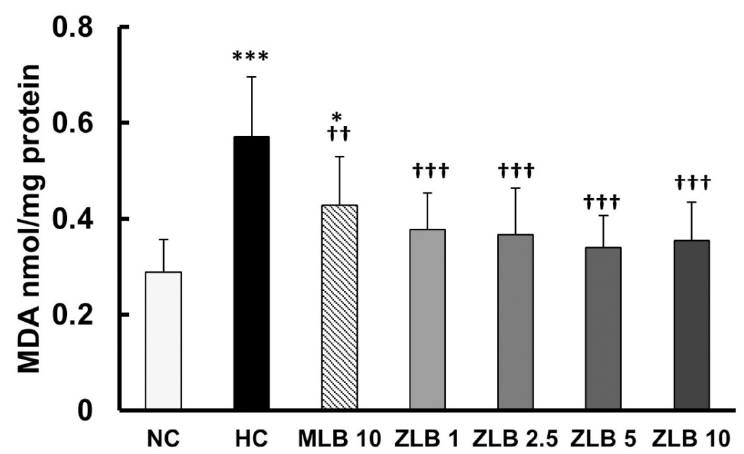
Figure 7. E ff ects of MLB and ZLB on oxidation stress. Malondialdehyde (MDA), a byproduct of Figure 7. Effects of MLB and ZLB on oxidation stress. Malondialdehyde (MDA), a byproduct of lipid lipid peroxidation, was measured by a thiobarbituric acid reactive substances (TBARS) assay as an indicator of oxidative stress. NC, normal diet control; HC, high-fat-diet (HFD) control; MLB10, HFD with 10 mg / kg / day of MLB; ZLB1, ZLB2.5, ZLB5, and ZLB10, HFD with 1, 2.5, 5, and 10 mg / kg / day of ZLB. Values are expressed as mean ± SD (n = 6 per group). * P < 0.05 and *** P < 0.001 vs. NC group; †† P < 0.01 and ††† P < 0.001 vs. HC group.